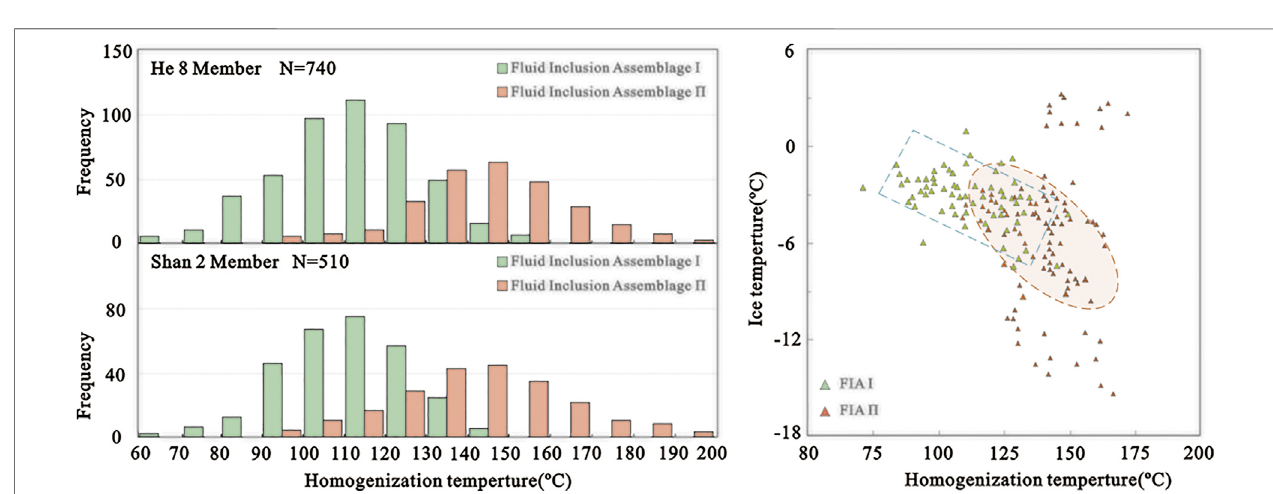
FIGURE 5 | Distribution of homogenization temperature in different FIAs in the Upper Paleozoic in Ordos Basin.